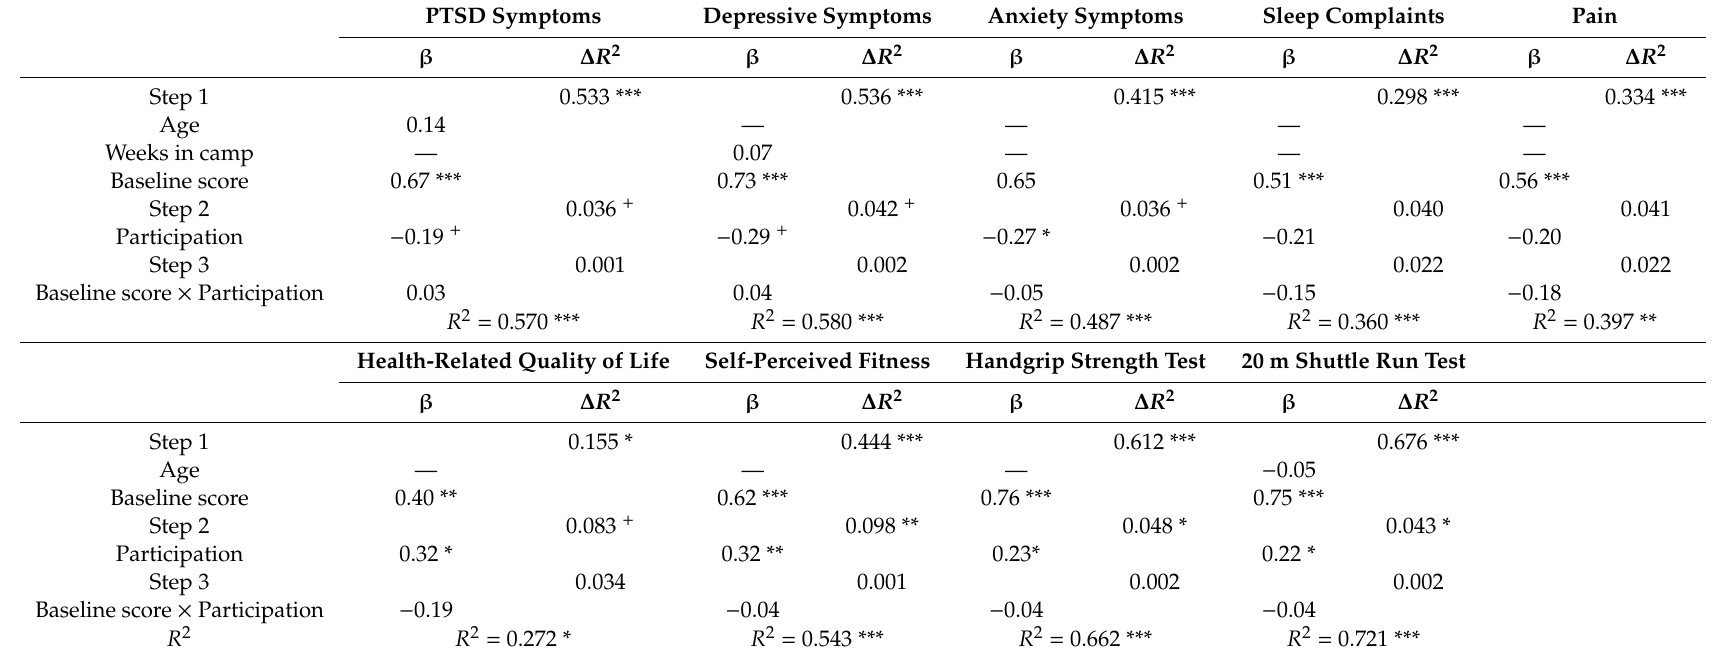
Table 2. Hierarchical stepwise regression analyses to predict post-intervention